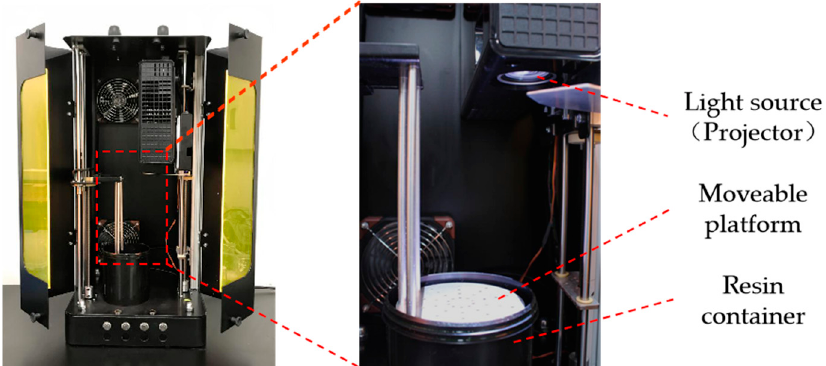
Figure 3. LumiForge, a mask-projection stereolithography 3D printer working from a bottom-up principle; its light source is provided by a projector.